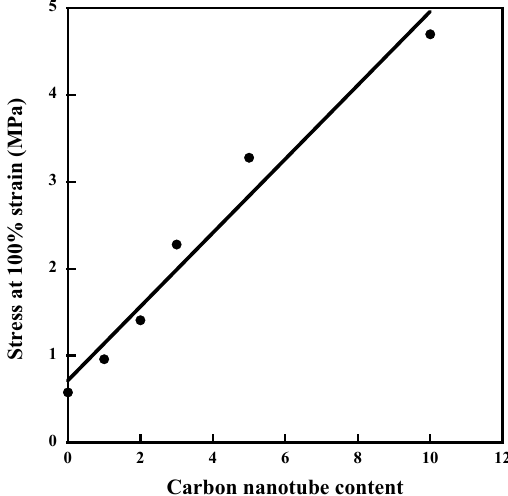
Figure 9. Stress at 100% strain for NR composites filled with multiwall carbon nanotubes (MWCNTs). Reproduced with permission from [69]. Copyright eXPRESS Polymer Letters, 2012.